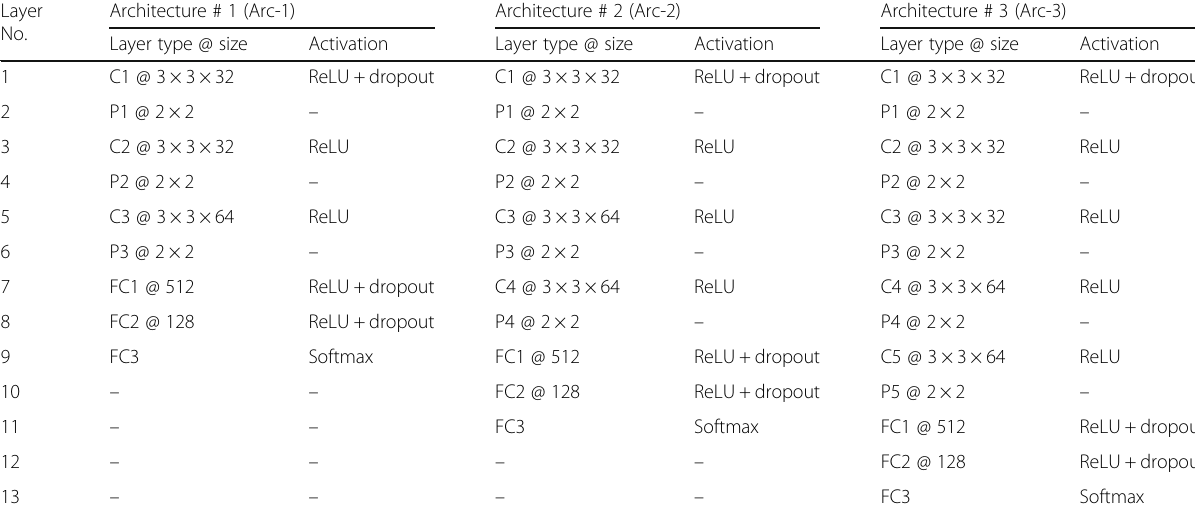
Table 1 Description of network architectures used for experimentation Layer